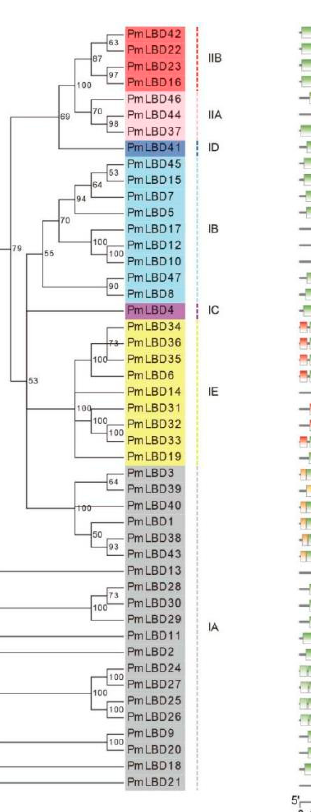
Figure 4. Sequence signature of LOB structural domain extracted from LBD protein sequence information. The motif1 is the zinc finger-like structure CX2CX6CX3C, motif2 is the GAS motif, and motif3 is the leucine-like zipper structure LX6LX3LX6L.